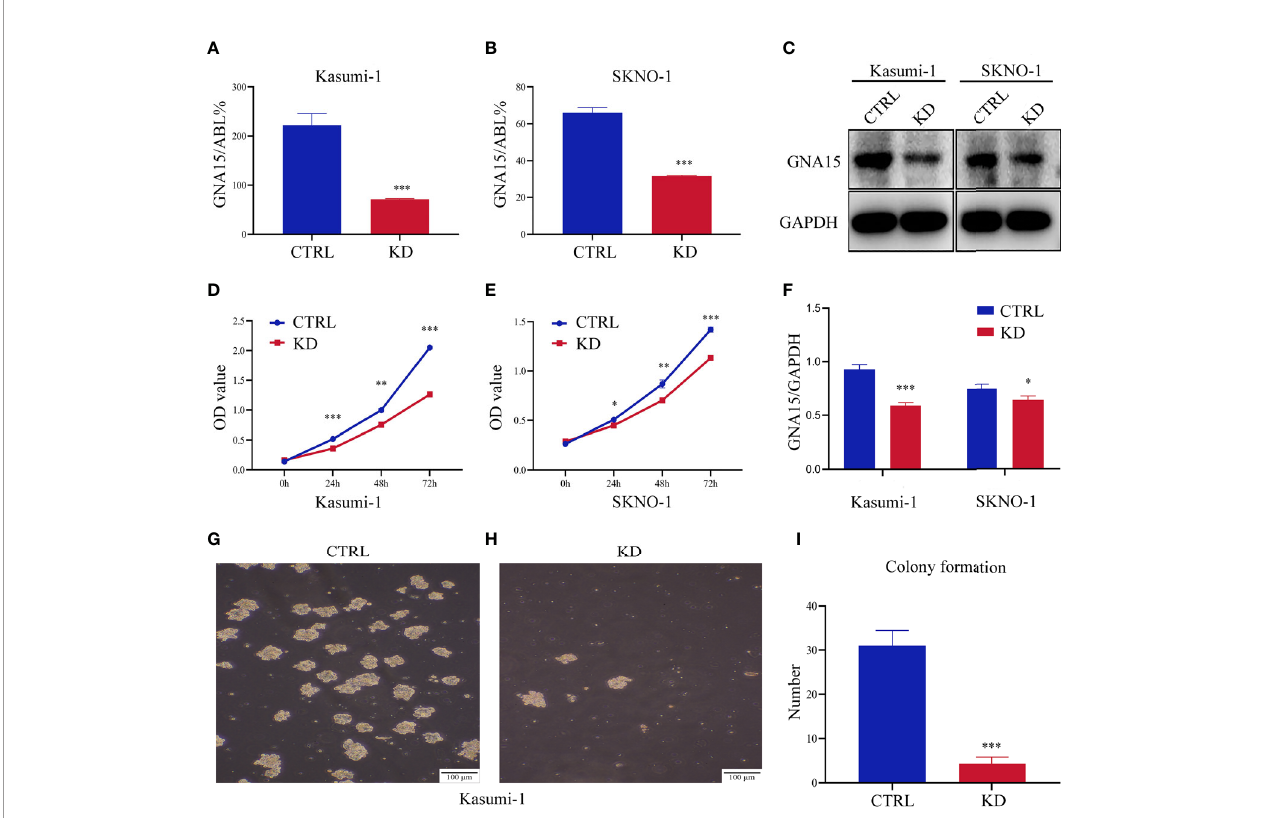
FIGURE 3 | Down-regulation of GNA15 inhibited cell proliferation and colony formation in AML cells. The ef fi ciency of GNA15 knockdown in the Kasumi-1 and SKNO-1 cell lines was veri fi ed by (A, B) real-time quantitative polymerase chain reaction and (C, F) Western blot, respectively. (D, E) Cell proliferation was detected by the CCK-8 assay in Kasumi-1 and SKNO-1 . (G – I) The colony formation of GNA15 -CTRL and GNA15 -KD in Kasumi-1. CTRL, control; KD, knockdown; * P < 0.05 compared with CTRL cells; ** P < 0.01 compared with CTRL cells; *** P < 0.001 compared with CTRL cells; Error bars indicate the standard